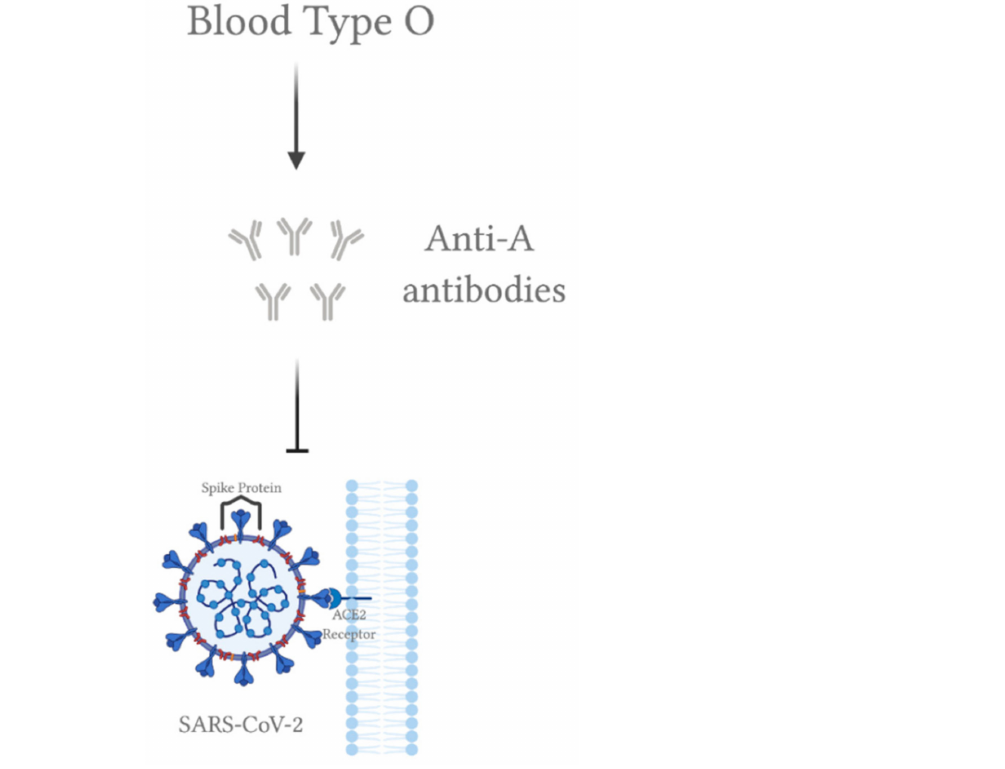
Figure 2. A possible mechanism for severe acute respiratory syndrome coronavirus 2 (SARS-CoV-2) inhibition by blood type O. Anti-A antibodies present in blood type O individuals inhibit the interaction between the S protein of SARS-CoV-2 and ACE2 receptor in host cells. All of the figures were created with